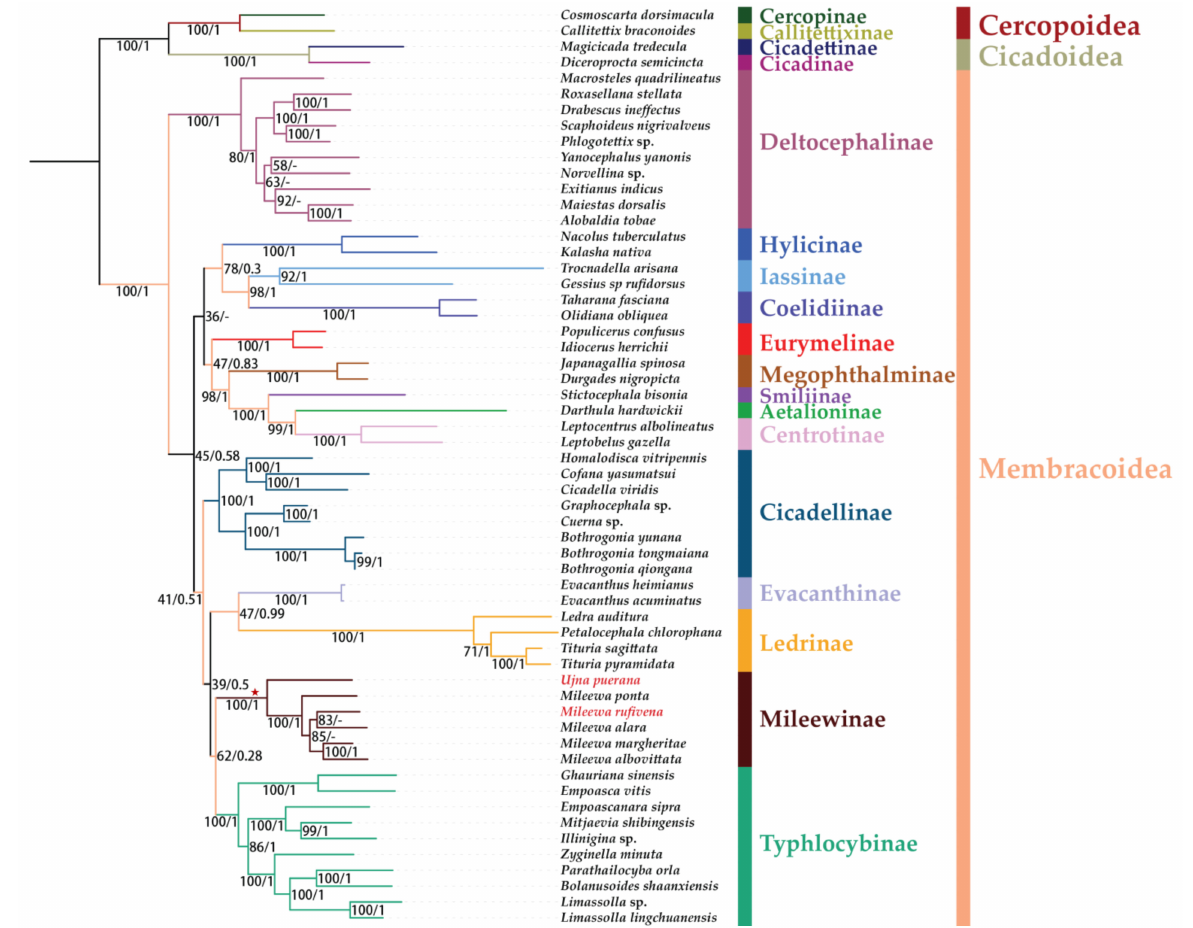
Figure 10. Phylogenetic tree inferred from the ML method based on AA dataset and the BI method based on the PCG12 dataset. Supports at nodes are bootstrap support values (BS) and posterior probabilities (PP). “-” indicates the clades or species are